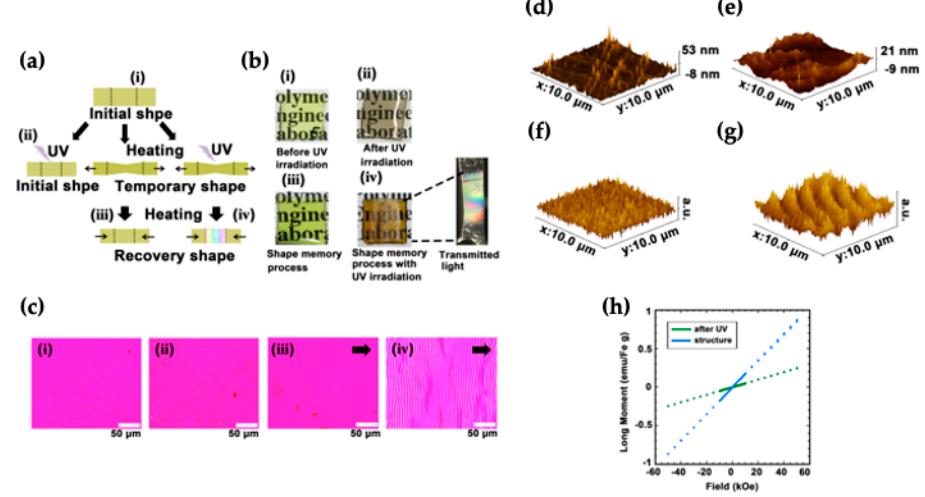
Figure 7. ( a ) Preparation of FeCl 3 -oriented hybrid films. ( b ) Photographs of Ti15TB40Fe5 after the (iii) shape memory and (iv) UV irradiation and shape-memory processes. ( c ) Photographs of Ti15TB40Fe5 after each process and state, with the image (iv) expanded to show a photograph of the transmitted light. The white bar represents 50 mM. AFM images of each state of Ti15TB40Fe5 after ( d ) UV irradiation and ( e ) UV irradiation and the shape-memory process. MFM images of each state of Ti15TB40Fe5 after ( f ) UV irradiation and ( g ) UV irradiation and the shape-memory process. ( h ) Magnetometry measurements of Ti15TB40Fe5 after UV irradiation (green plot) and the shape-memory process (blue plot). From ref. [85]. Adapted with permission from Ref. [85]. Copyright 2022, The Royal Society of